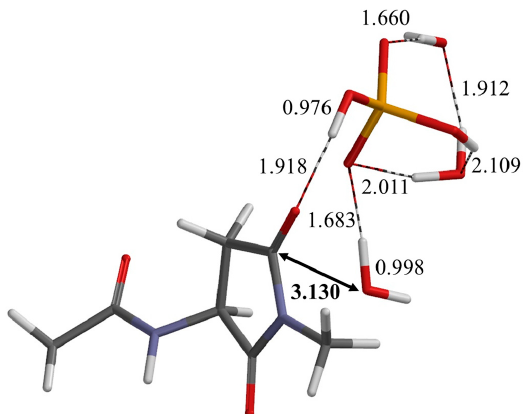
Figure 8. The geometry of the product complex (PC). This complex is directly connected to TS2 (Figure 7). Selected interatomic distances are shown in Å. Grey: carbon; white: hydrogen; blue: nitrogen; red: oxygen; orange: phosphorus. Table 1. The main-chain dihedral angles φ and ψ , and the side-chain dihedral angle χ 1 (in degrees) of the optimized geometries 1 .